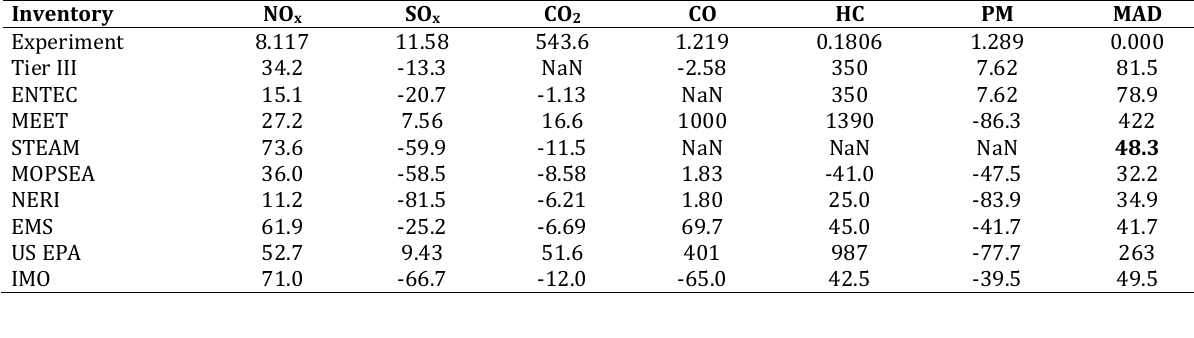
Table 6: Inventory deviations from the experimentally measured combined hourly emission amounts in % for the main engine plus the auxiliary engines at berth. The experimentally measured combined hourly emission amounts are given in the first row in kg/h. The mean absolute deviations in % are shown in the last